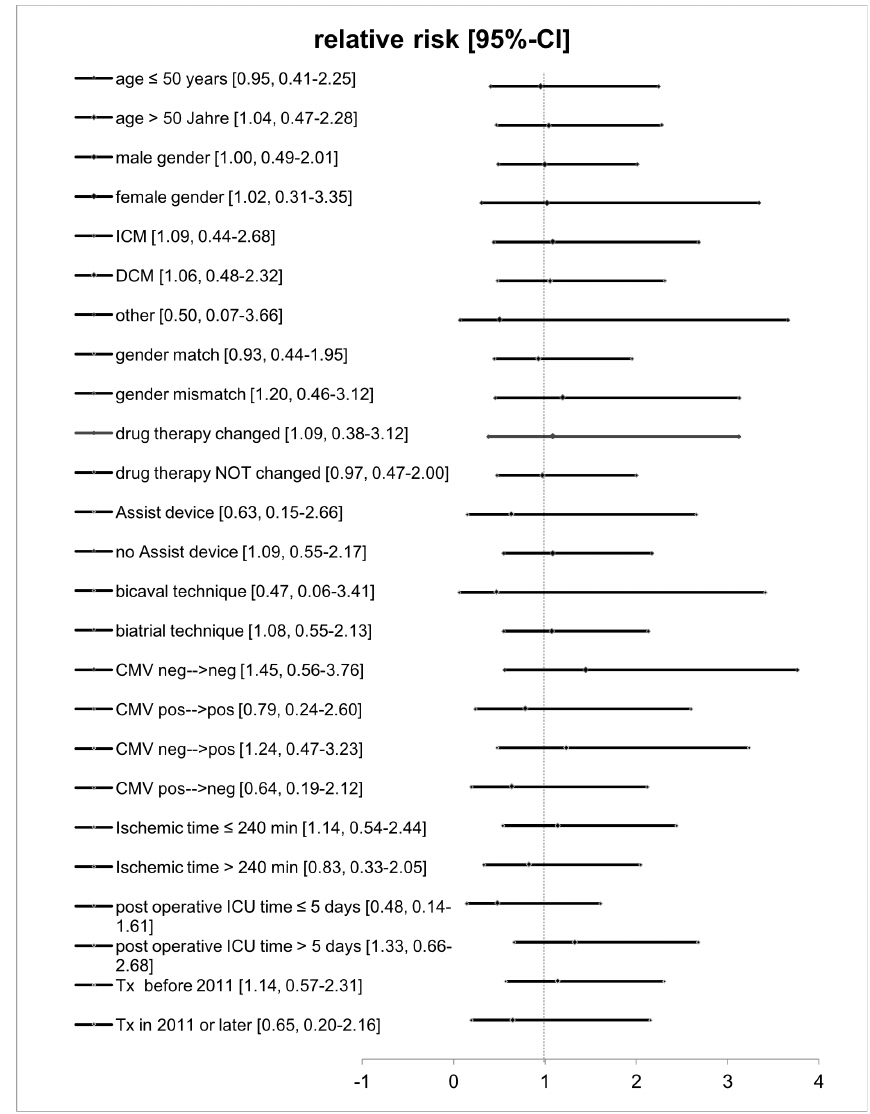
Fig 3. Risk factors for acute allograft rejection. Subgroupanalyseswere conductedto identify cohorts at higherrisk for acute allograft rejection. None of the subgroupsinvestigatedsignificantly differed from the total cohort regardingprobabilityof rejection. CI =